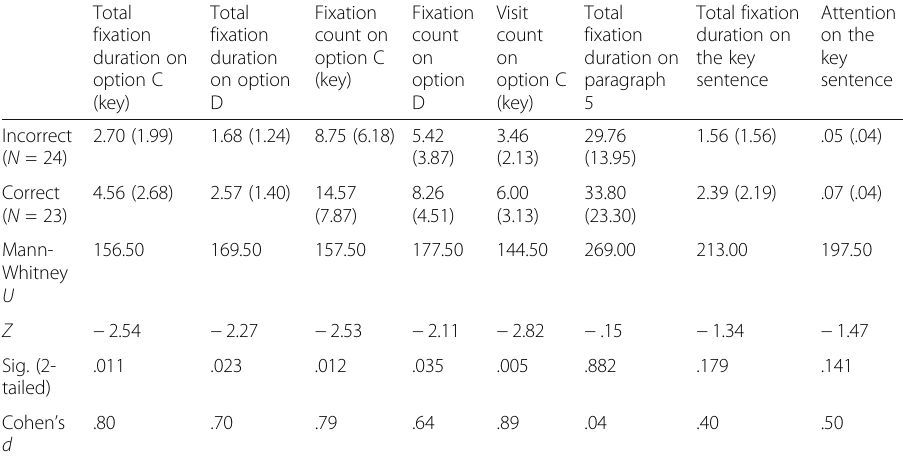
Table 7 Eye-tracking statistics for item 8